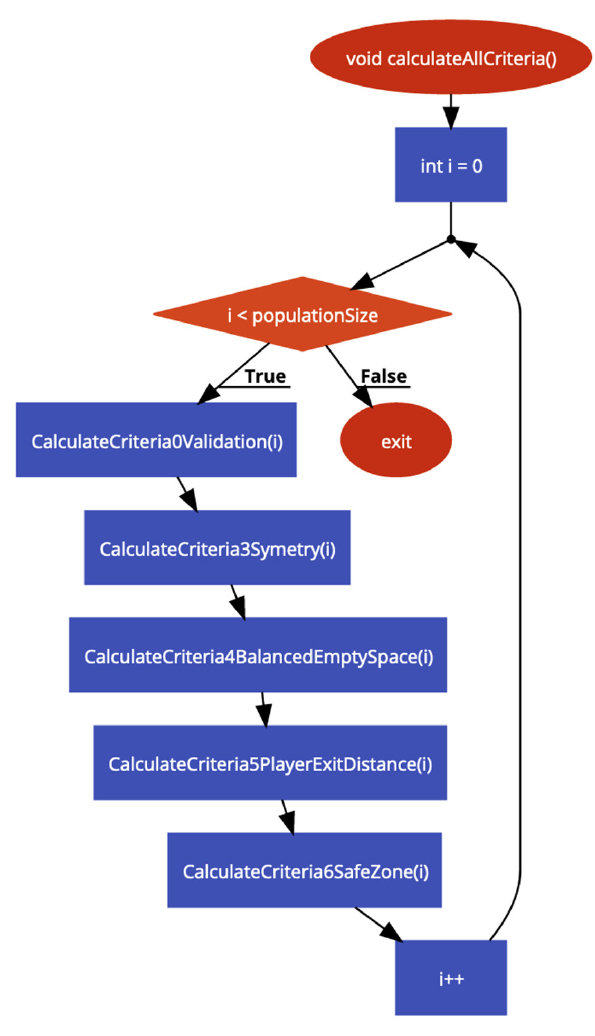
Figure 5. Criteria